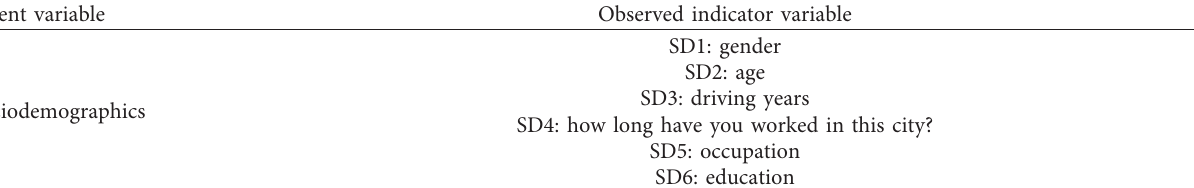
Table 1: Variable used in model.